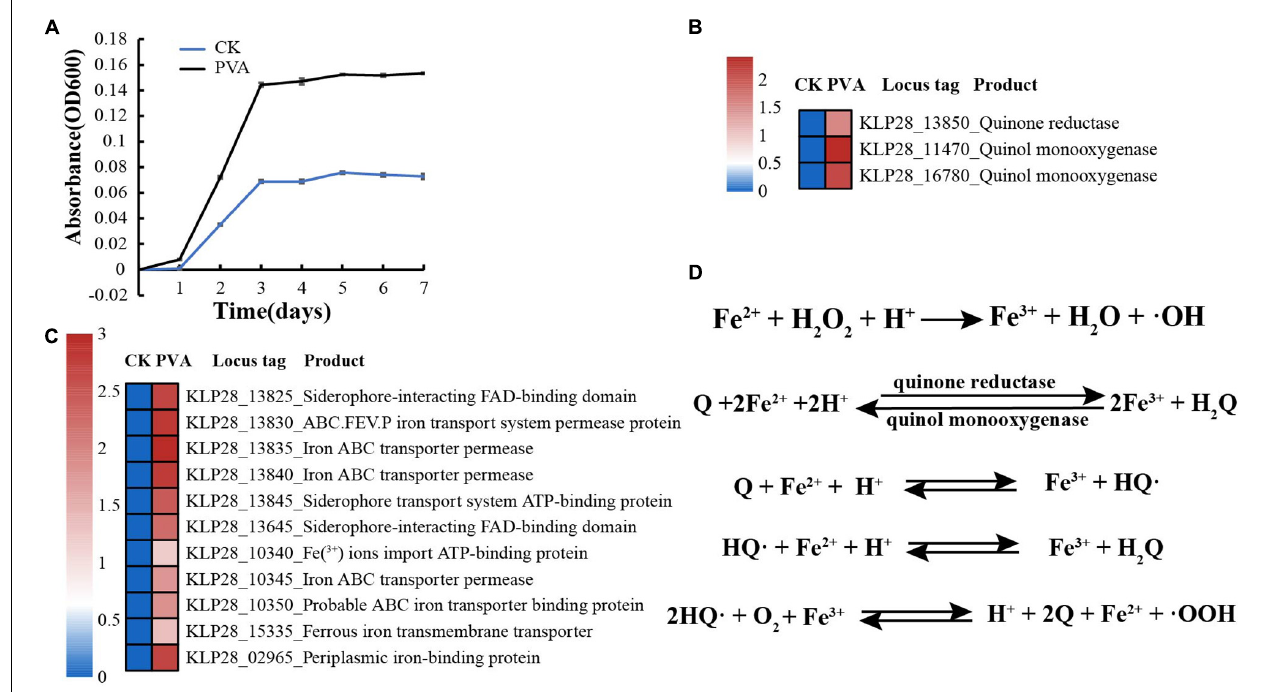
FIGURE 4 | Strain TYQ2 effectively utilizes PVA. (A) Growth assays of strain TYQ2 in the 1/10 2216E medium supplemented either without or with 10 g/L PVA. (B) A heat map based on transcriptomics analysis showing the up-regulation of genes encoding the quinone reductase and quinol monooxygenase. (C) A heat map based on transcriptomics analysis showing the up-regulated genes related to iron/ferrous iron transmembrane transporters and relevant FAD/ATP-binding proteins. (D) The proposed Fenton reaction driven by the redox process of quinone and quinol. Q, quinone; H 2 Q, quinol; HQ, semiquinone; OOH, perhydroxyl